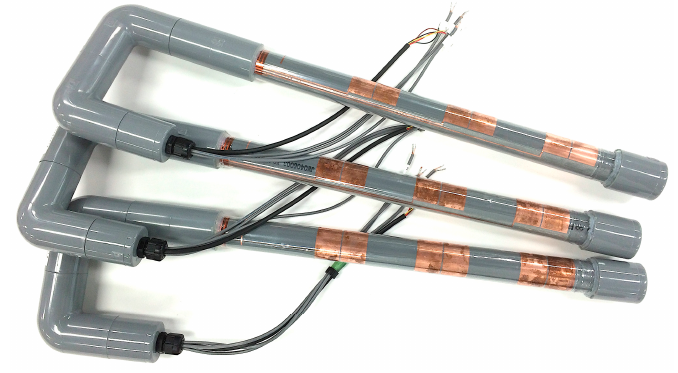
Figure 2. Developed soil moisture sensors.